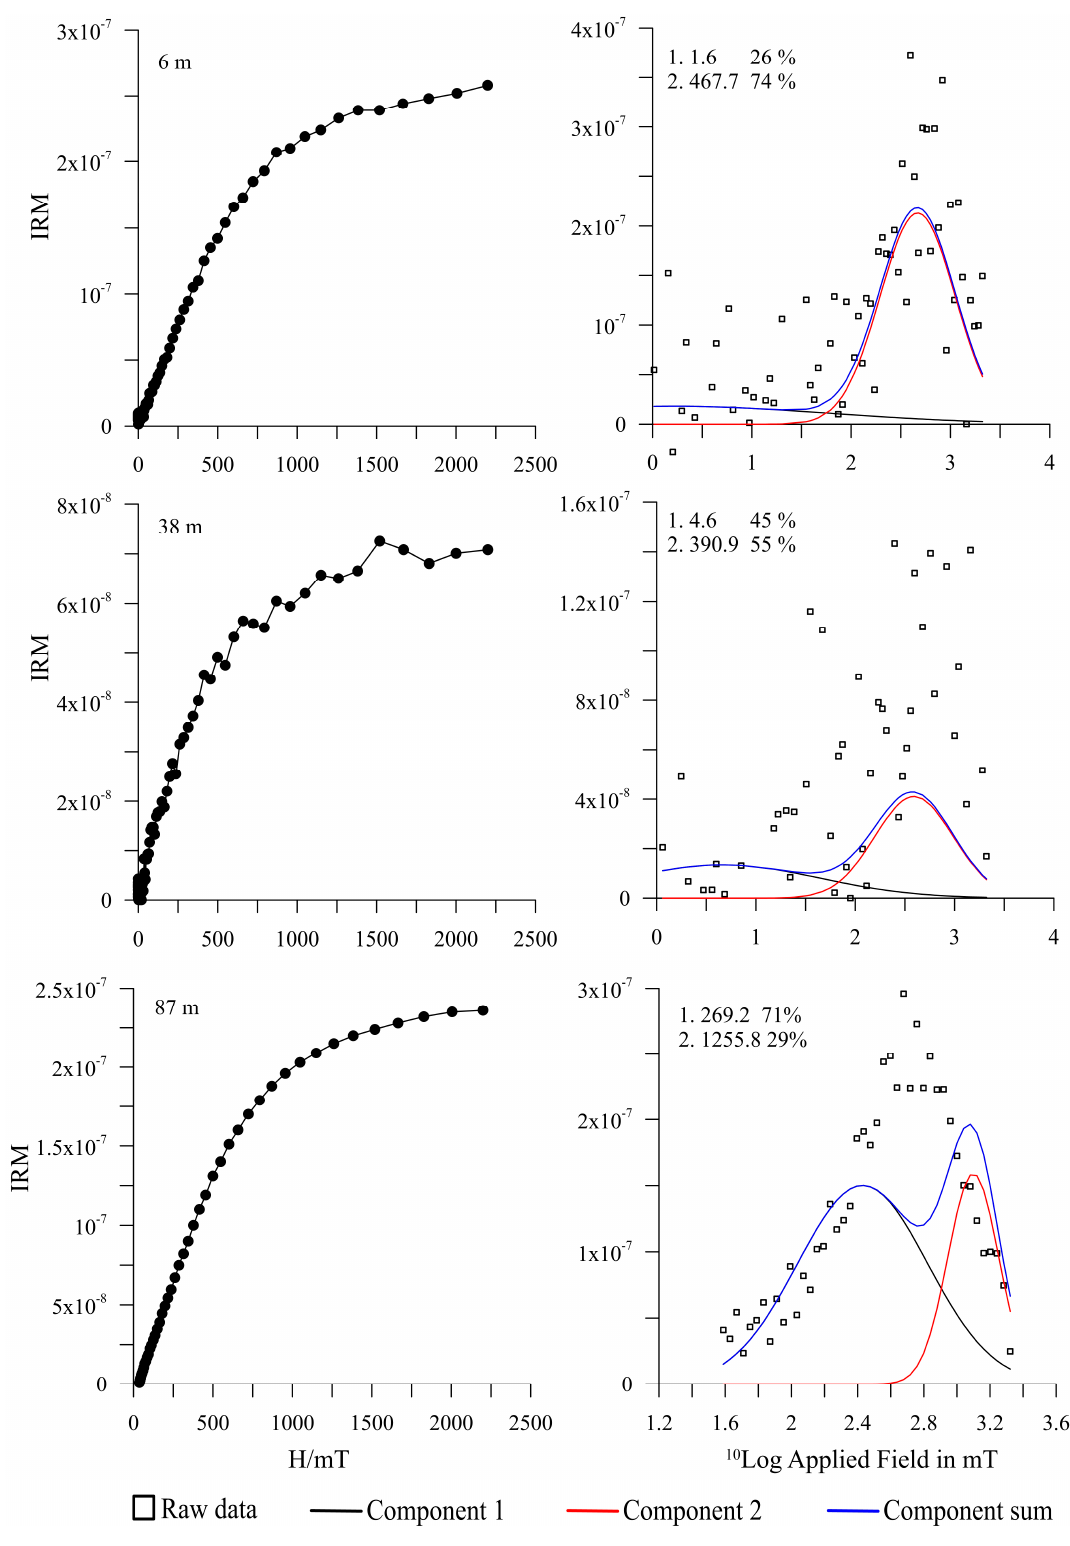
Figure 4. IRM acquisition curves ( left ) and corresponding IRM component analysis ( right ) of rep- resentative samples from the TTH-D section. Components 1 and 2 represent low and high coercivity, respectively, with B 1/2 (the field at which half of the saturation IRM is reached) and relative contribu- tions to saturation